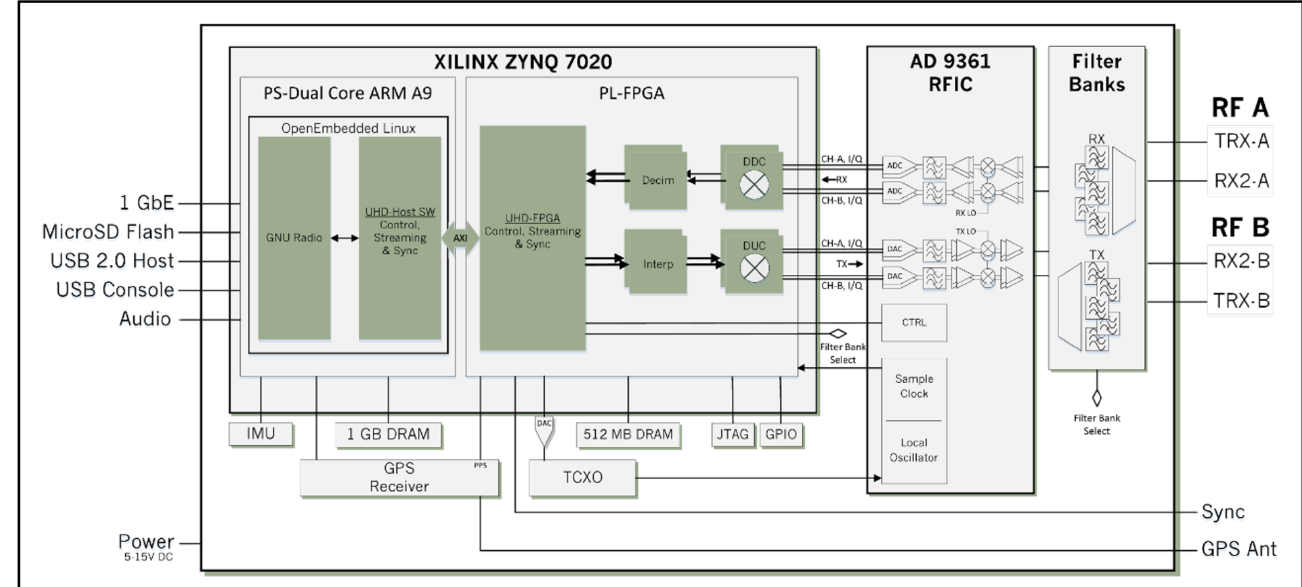
Figure 6. Software defined radio structure.